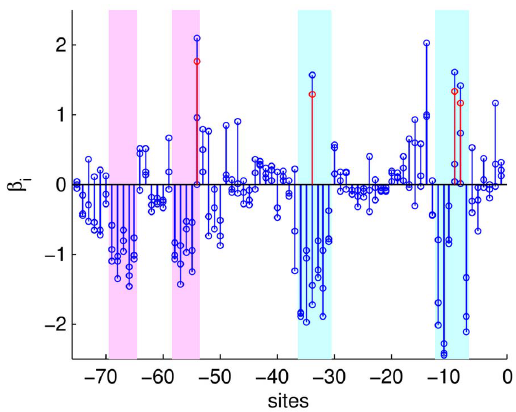
Figure 1. Stem plot of the linear coefficients. Three circles on each stem represent the changes in phenotype for each of the three possible mutations per site. CRP and RNAP are known to each bind at two sites (magenta and cyan areas). Red circles correspond to the mutations needed to get the consensus sequences. TTGACA(N) TATAAT for RNAP [29], but the wild type is 18 only four mutations away. Four of the large positive coefficients in Fig. 1 (positions 2 54, 2 34, 2 9, 2 8, red circles) correspond to the mutations needed to get the consensus sequences.